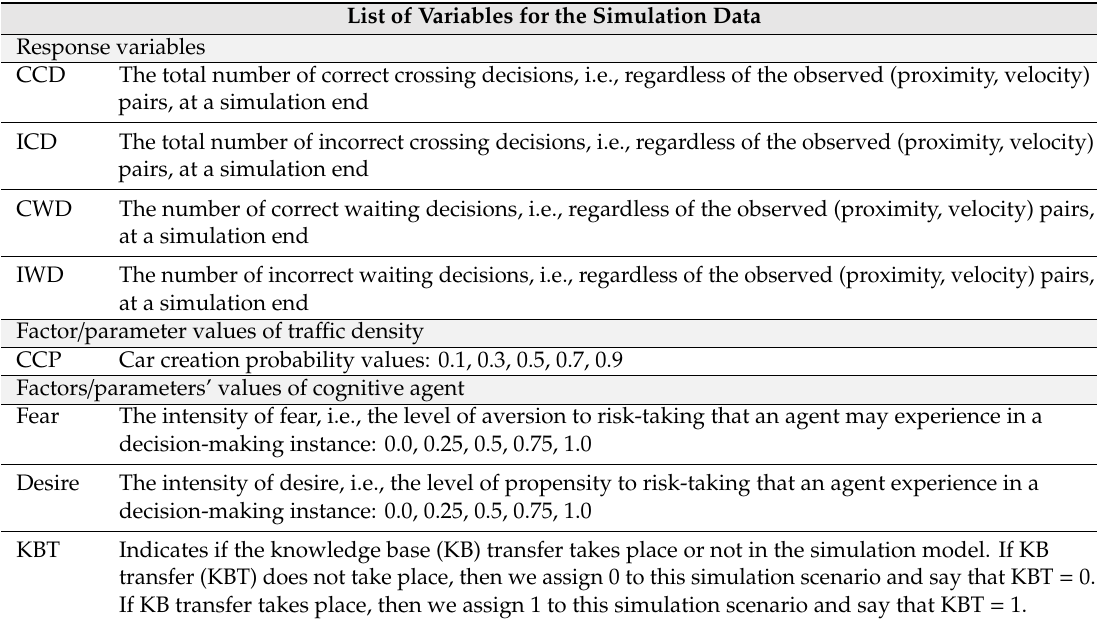
Table 1. List of the simulation model response variables and parameters of the simulation